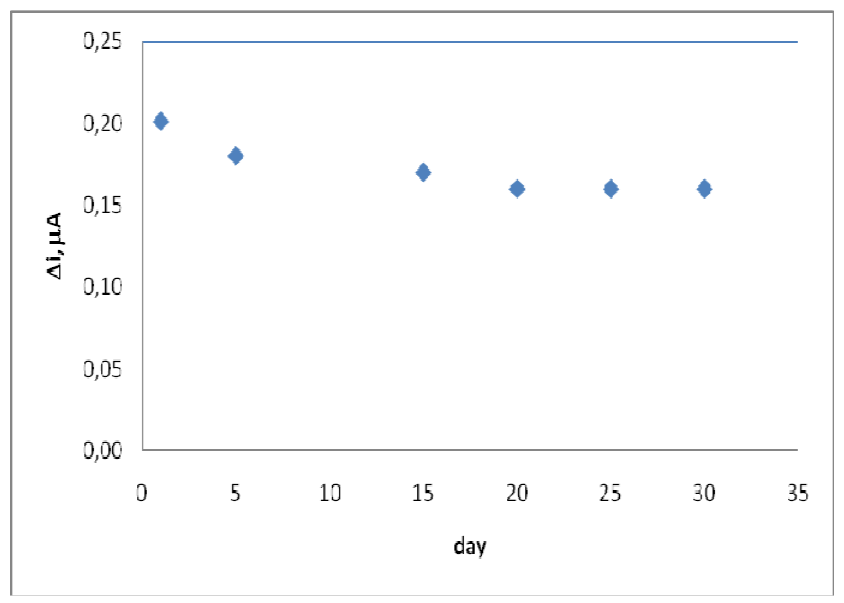
Figure 7 . Storage stabilization of the enzyme electrode (0.05 M, pH 9.0 borate buffer, 25 o